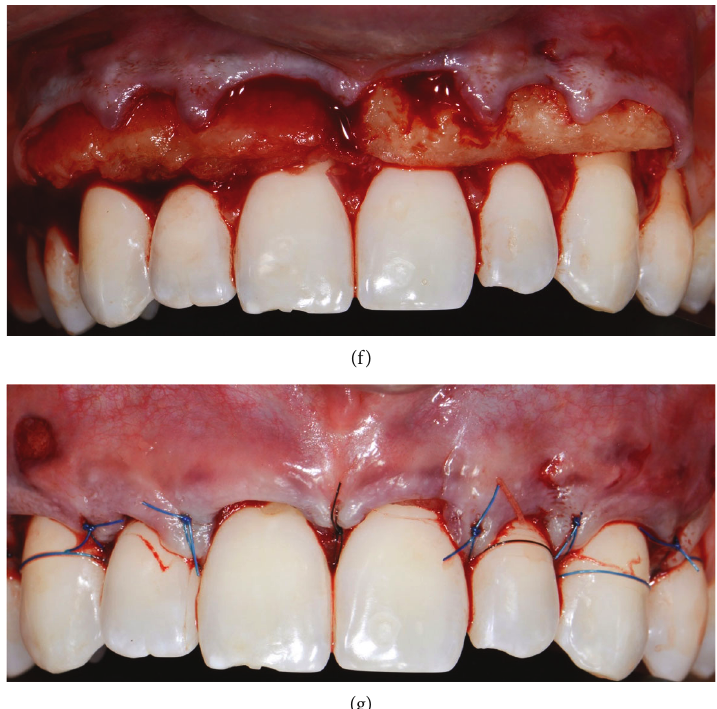
Figure 1: Preoperative evaluation and surgical procedure. (a) Clinical view before surgery, (b) a surgical fl ap with a split – full – split thickness con fi guration was raised, (c) volume-stable collagen matrix (Fibro-Gide, Geistlich Pharma AG, Wolhusen, Switzerland) before platelet-rich fi brin functionalization, (d) functionalization of the collagen matrix with injectable platelet-rich fi brin (i-PRF), (e) collagen matrix after functionalization, (f) positioning of the matrix impregnated with injectable platelet-rich fi brin (i-PRF) in the surgical site, (g) tension- free fl ap repositioning and